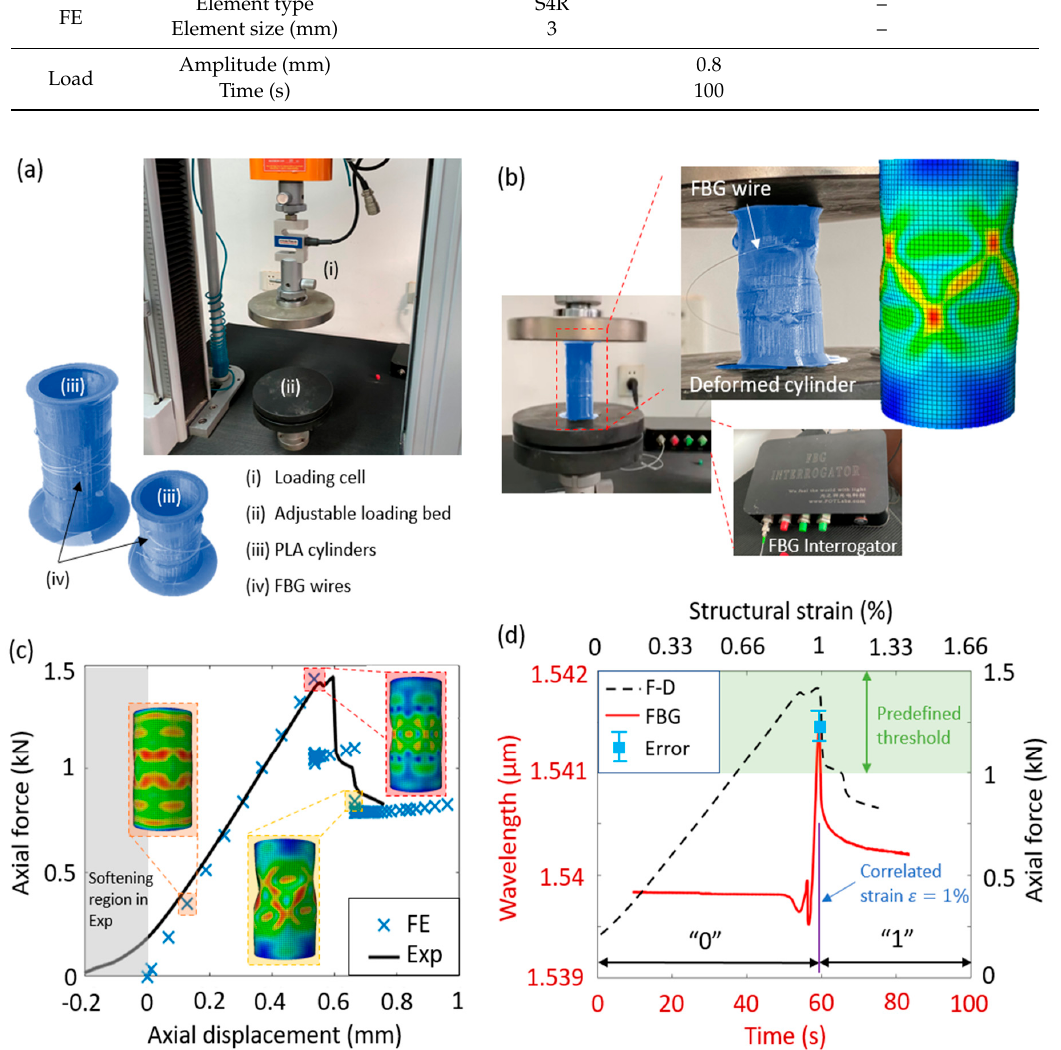
Figure 2. Experiments and numerical simulations of the FBG cylinders subjected to external loading. ( a ) 3D printed cylinders coiled by FBG wires and the loading machine in the experiments. ( b ) Experimental setup, testing results, and numerical simulations of the deformation configurations of the cylindrical samples. ( c ) Comparison of the force–displacement relations between the experimental and numerical results and the deformed shapes at the limit states. ( d ) FBG detection and force–displacement relation of the cylinder and the conversion of structural instability into binary data, using the predefined threshold of wavelength of 1.541 µm.